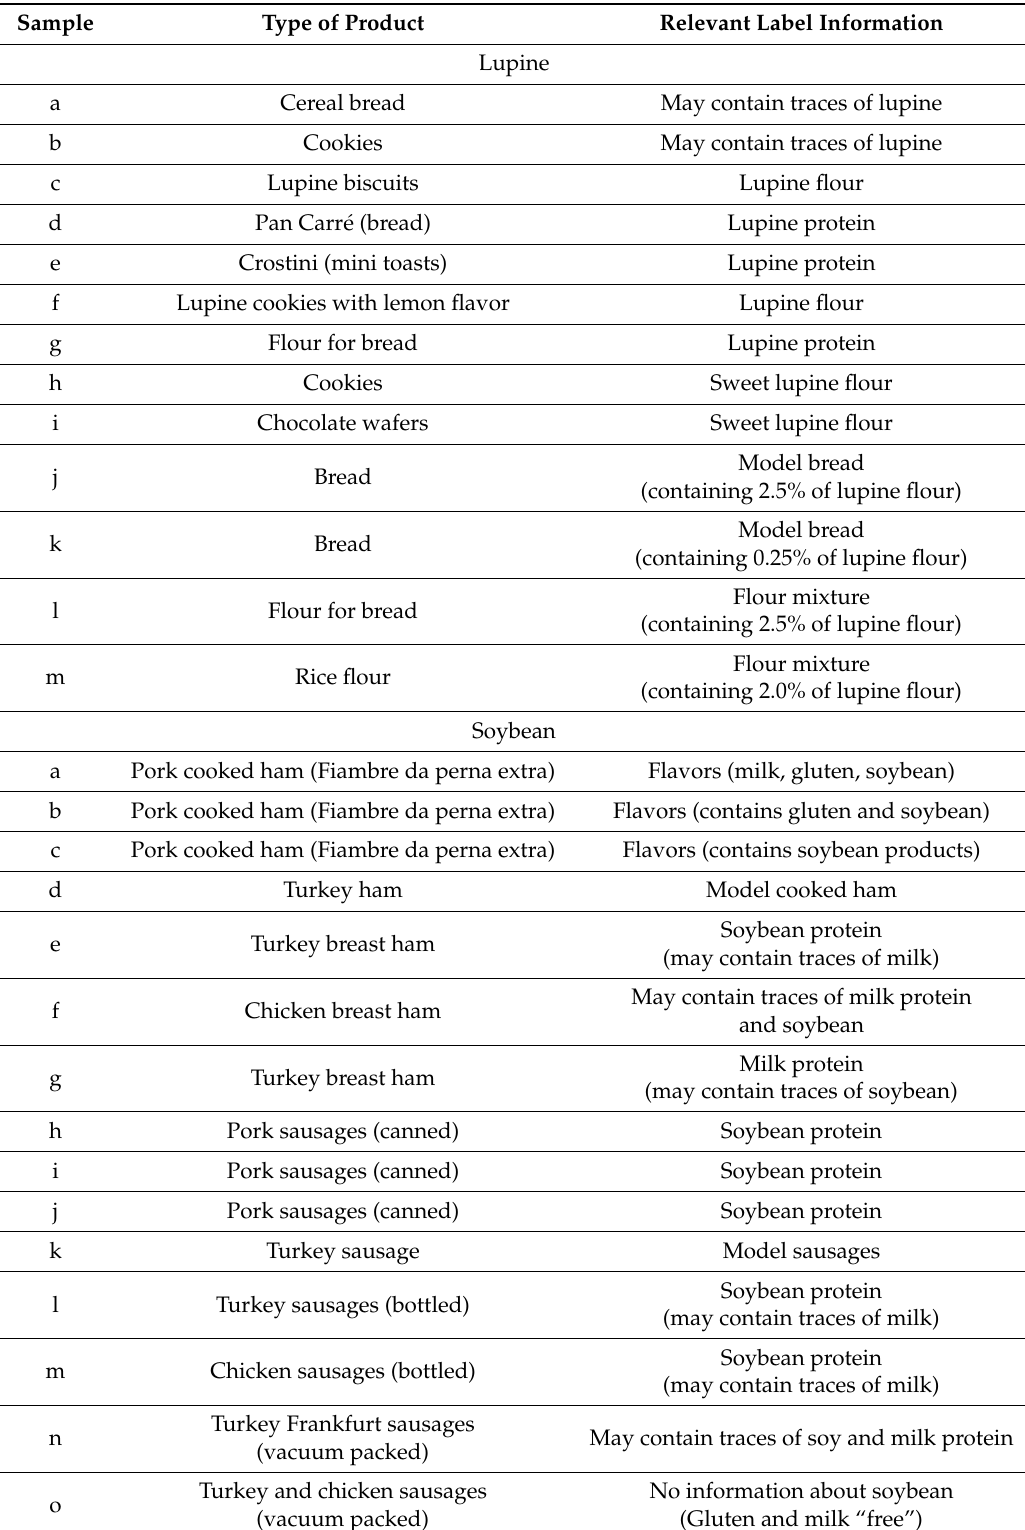
Table 1. List of commercial and model samples tested in this